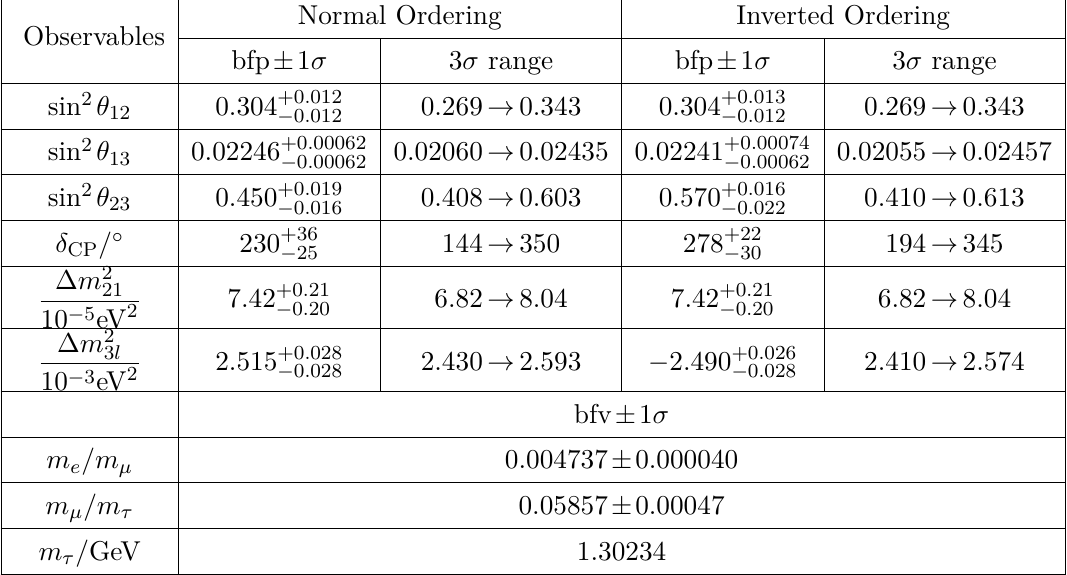
Table 7. Allowed ranges for the neutrino oscillation parameters obtained from global analysis of the data, and values of the charged-lepton mass ratios. Here, we use the NuFIT v5.1 results with Super- Kamiokanda atmospheric data [69]. Note that ∆ m 2 for IO. The charged-lepton masses are taken from [76] with tan β = 10 and SUSY-breaking scale M SUSY = 10